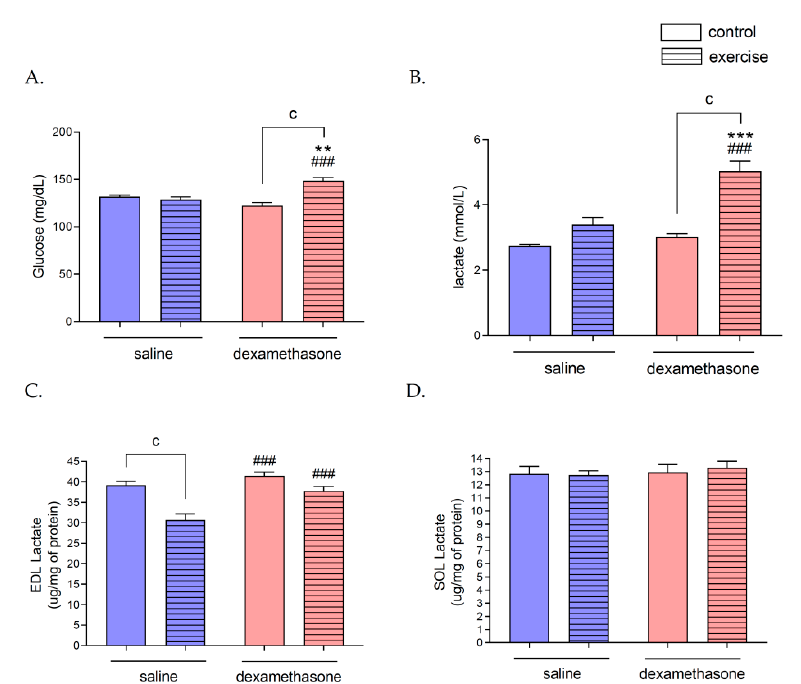
Figure 2. The effects of Dex treatment, swimming, and a combination of these factors on glucose and lactate concentrations in rat plasma and skeletal muscles. Blood Glucose (Glu) ( A ), Lactate (LA) ( B ), were measured in rats’ plasma. Soleus LA ( D ) and EDL LA ( C ) were measured in deproteinized muscle samples. There were significant differences between the groups: cp < 0.001 between the indicated groups; ### p < 0.001 between the indicated group and saline exercised group; ** p < 0.01, and *** p < 0.001 between the indicated group and saline control group. The data are presented as the means ± SEM ( n = 10 in each